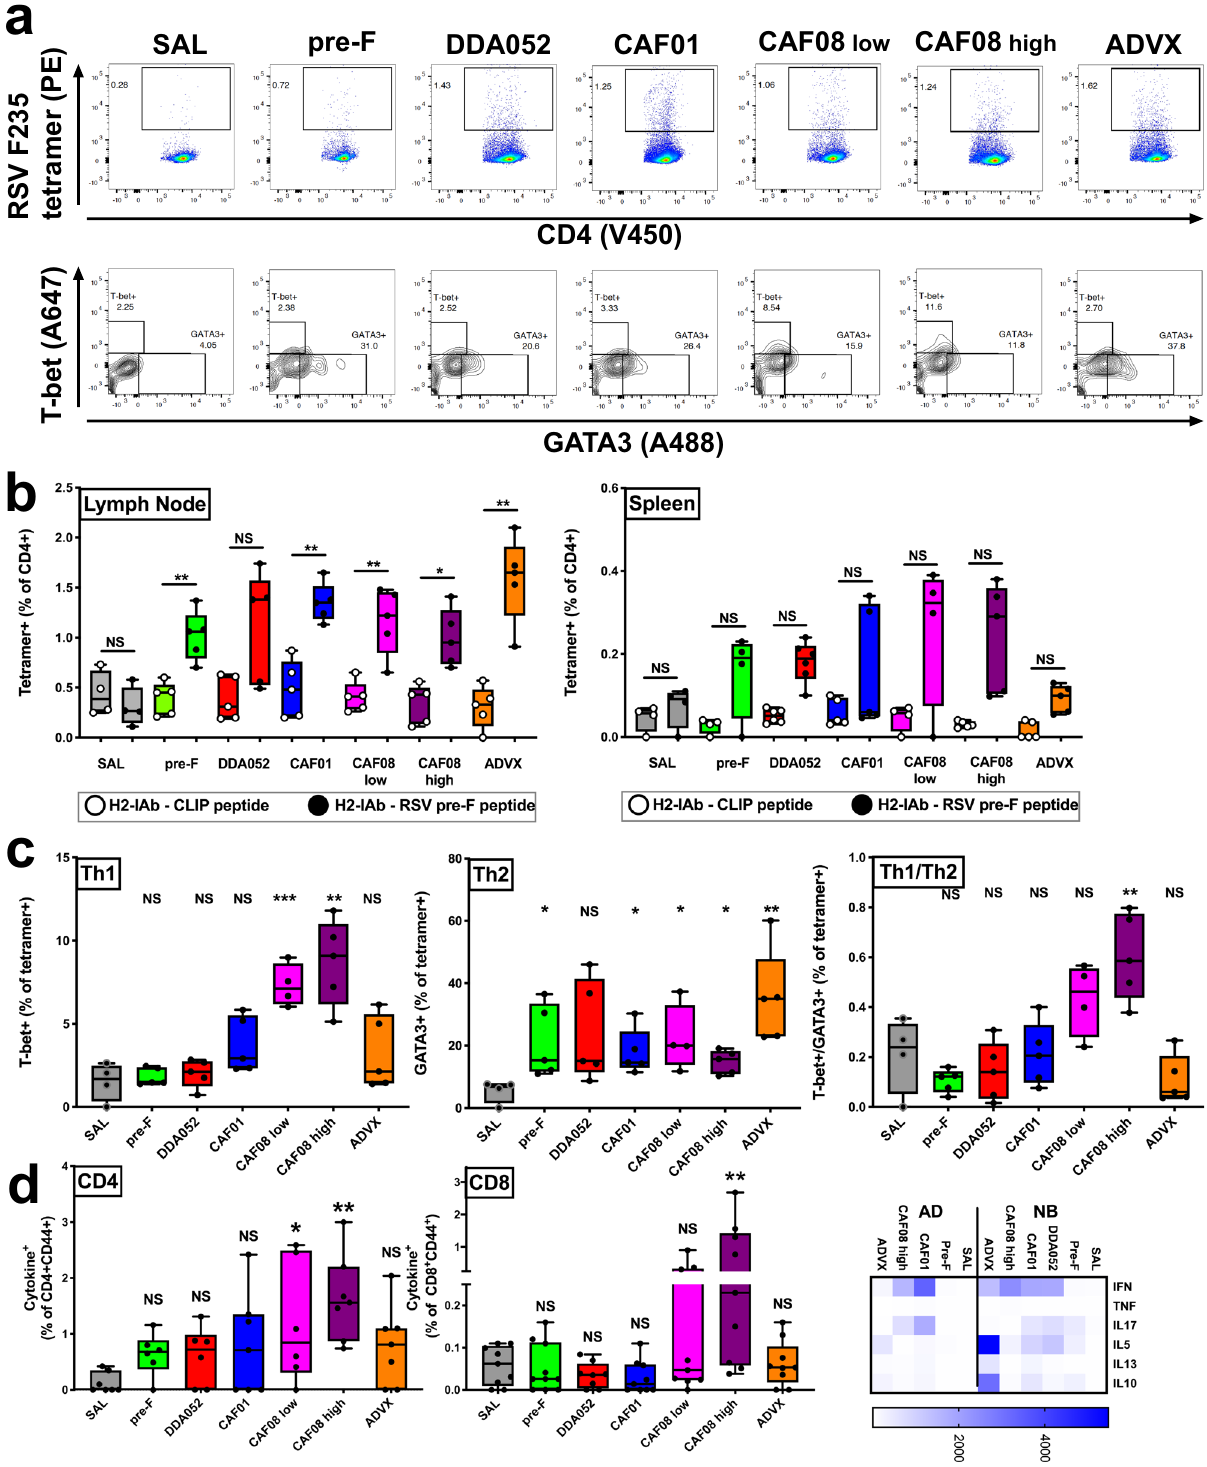
intrinsic neonatal Th2 bias 43